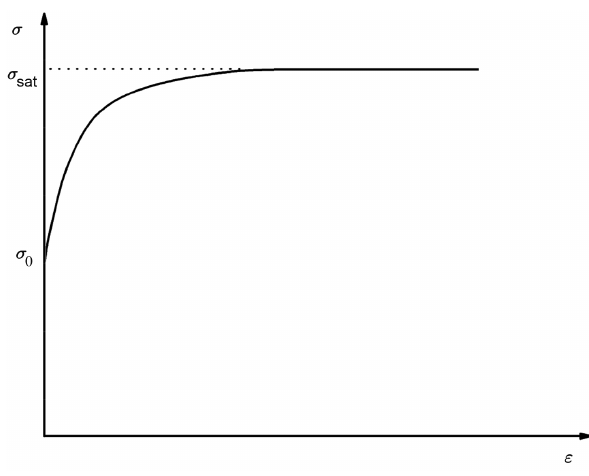
Figure 3: A schematic of true stress – strain curve characteristic of DRV behavior.